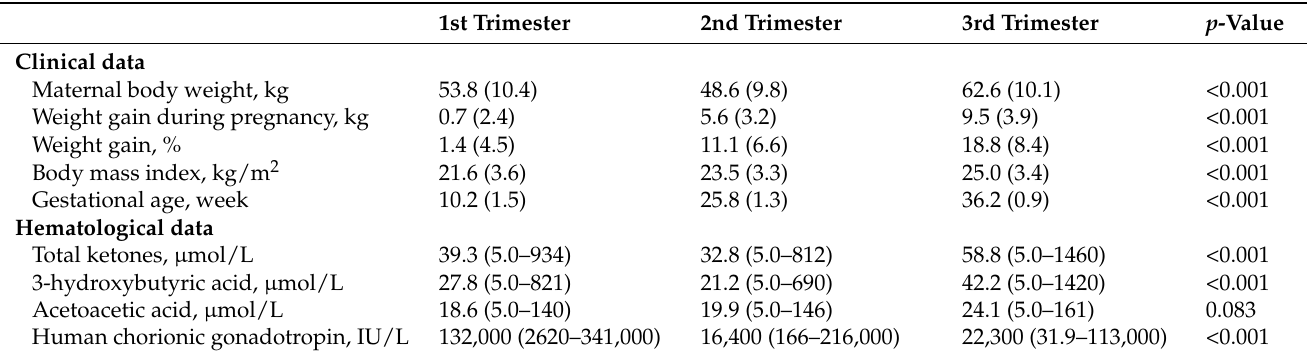
Table 2. Hematological data of 245 pregnant